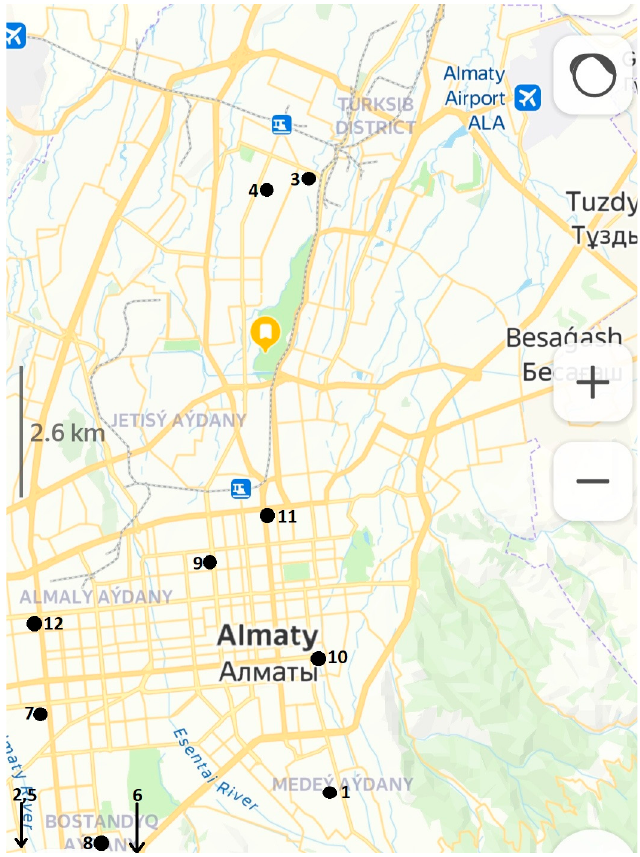
Figure 1. Location of included salons in Almaty, Kazakhstan (from yandex.kz). Measured 5-min mean respirable PM concentrations ranged from 0 to 6.3 mg/m 3 (median 0.073 (IQR 0.043; 0.157), geometric mean 0.083 mg/m 3 ) with severe left skewness (8.40). Of the overall count of 11,831 data points, 5-min mean concentrations exceeding 0.1 mg/m 3 were found in 4479 data points (38% of data), exceeding 0.2 mg/m 3 in 2218 data points (19% of all data), and exceeding 0.5 mg/m 3 in 614 points (5% of the data). Very high concentrations above 1 mg/m 3 were recorded in 205 data points, which corresponded to 2% of the overall work time. All further analyses represent grouped daily data (122 days), either median or geometric means. Daily median respirable PM concentrations were highly variable and ranged from 0.013 to 0.666 mg/m 3